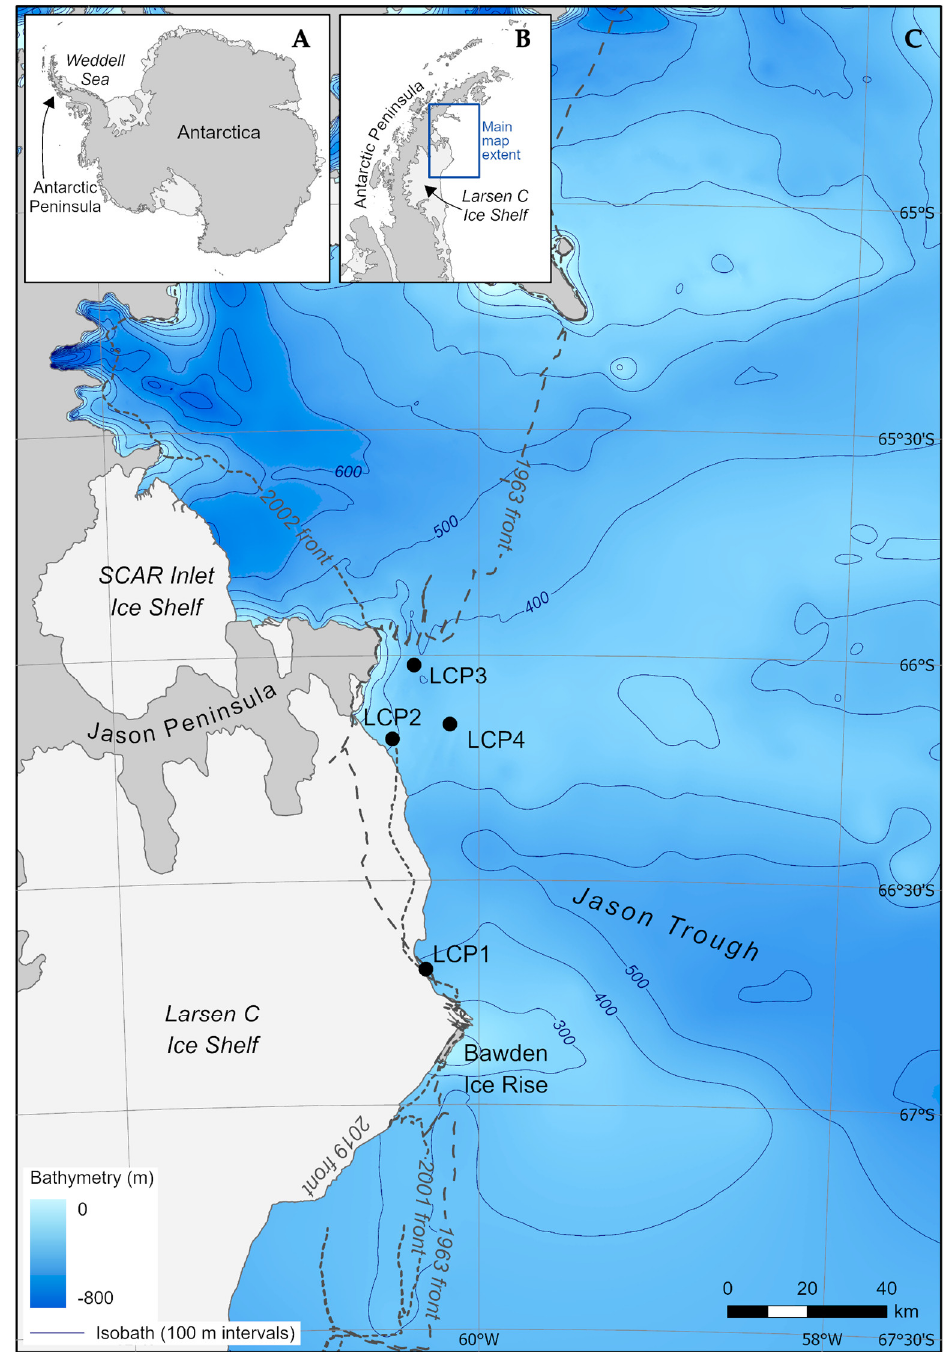
Figure 1. Study zone and sites. Inset ( A ) Antarctica indicating the Antarctic Peninsula and Weddell Sea; inset ( B ) Antarctic Peninsula indicating Larsen C Ice Shelf and the extent of the main map; and ( C ) main map of western Weddell Sea study area, showing the modern-day (2019) ice front and the locations of continental shelf study sites, LCP1-4 (black circles), investigated for benthic megafaunal assemblages. Light gray indicates ice shelves and darker gray indicates ice-covered land/grounded ice. Bathymetry is from the International Bathymetry Chart of the Southern Ocean v2 [79], with 100 m contours. The ice-shelf fronts are from Cook and Vaughan [9], Cook et al. [80] and Christie et al.